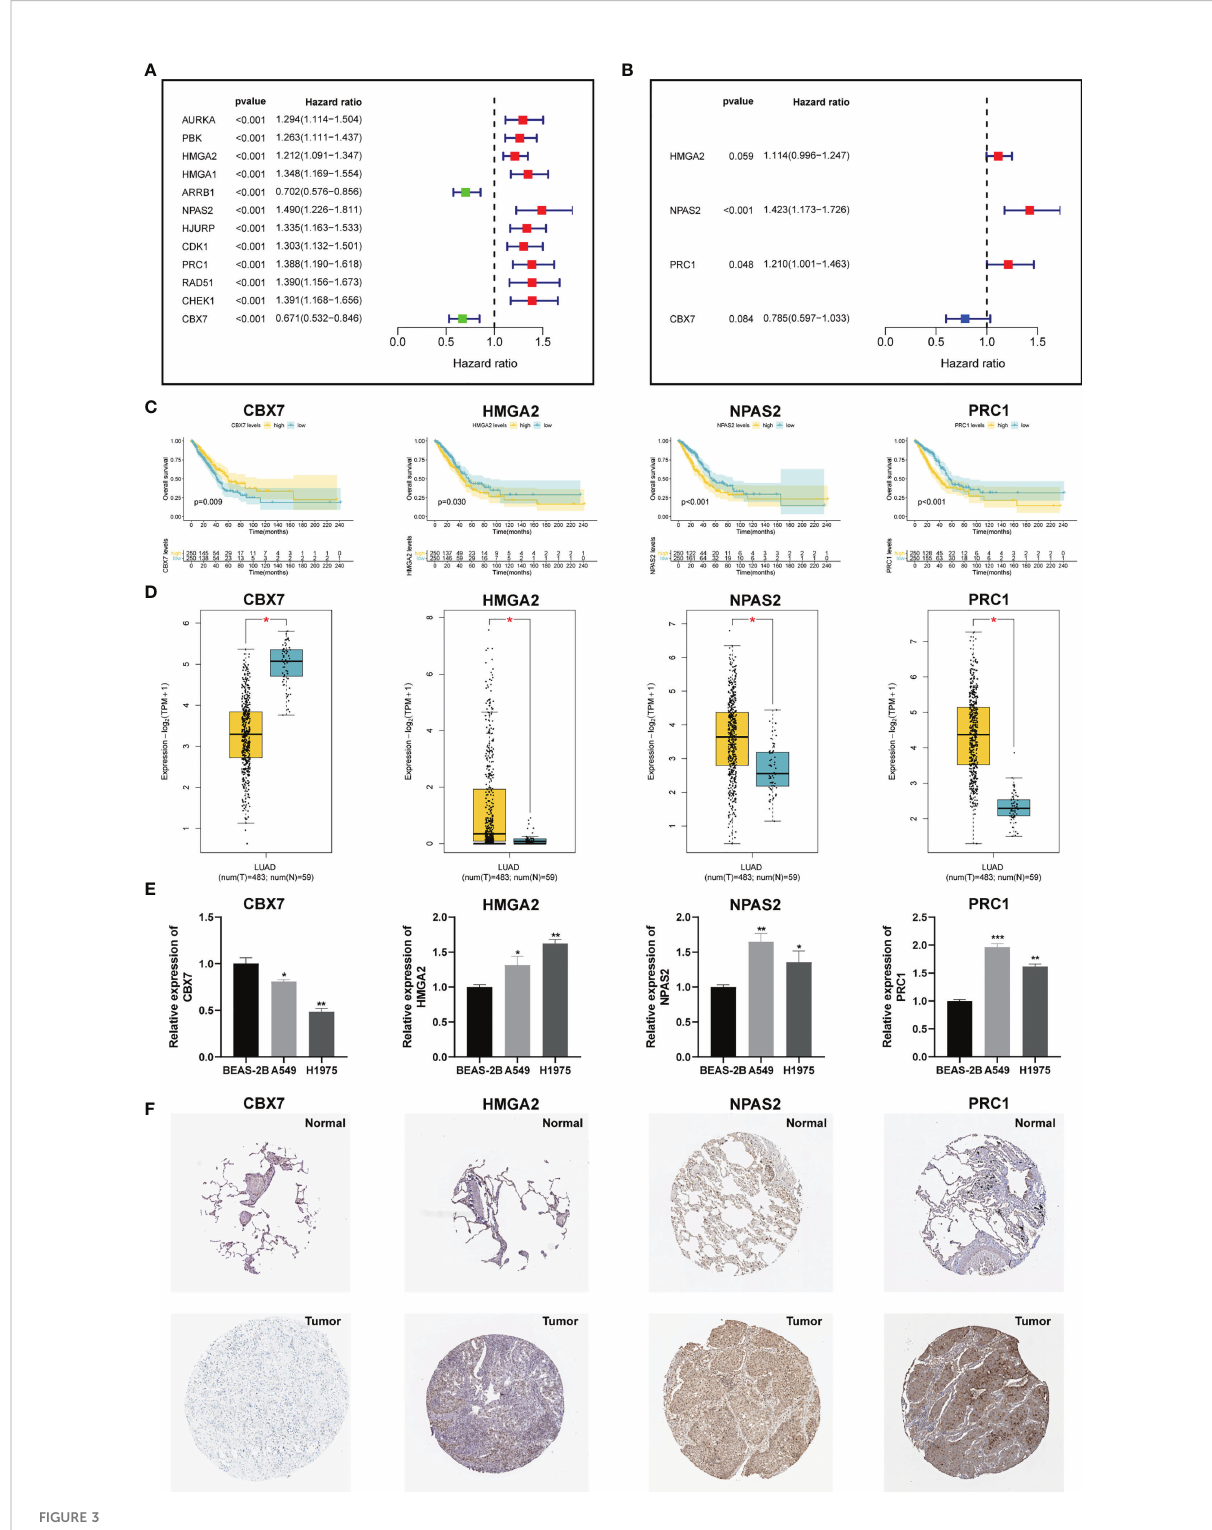
FIGURE 3 Construction of a CRs-based signature (CRBS). (A, B) Univariate and multivariate Cox analyses for signature establishment. (C) Survival analysis of four model CRs. (D) Comparison of differential expression of four model CRs based on GEPIA2 online portal. (E) The expression of four model CRs in BEAS-2B, A549 and HCI-H1975 cells line. (F) Immunohistochemistry of the CGs according to the HPA database. *p < 0.05; **p < 0.01; ***p <